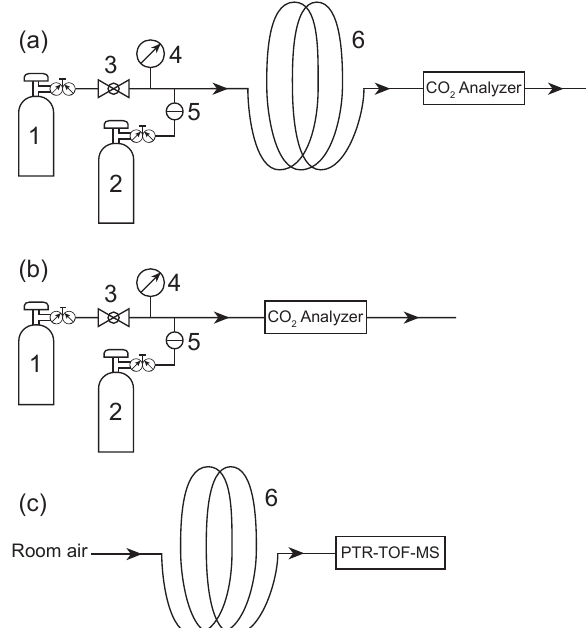
Fig. 2. The schematic drawings of the diffusion test system. 1: N 2 ; 2: 10% v/v CO 2 or 1ppmv propene gas; 3: ball valve; 4: pressure gauge; 5: two-way valve; 6: 3/8in. OD coiled tube (150m length). (a) CO 2 -spiked N 2 gas flows through the WASP tube into the CO 2 analyzer; (b) CO 2 spiked N 2 gas goes directly into the CO 2 ana- lyzer; (c) after the propene-spiked N 2 gas fills the WASP tube, the gas is analyzed with PTR-TOF-MS under a lower withdrawal flow